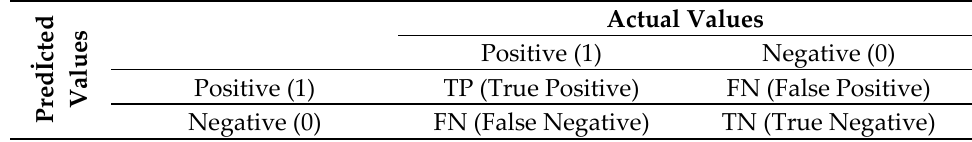
Figure 9. Confusion matrix. Table 3. F1-score values in the popularity classification of algorithms.